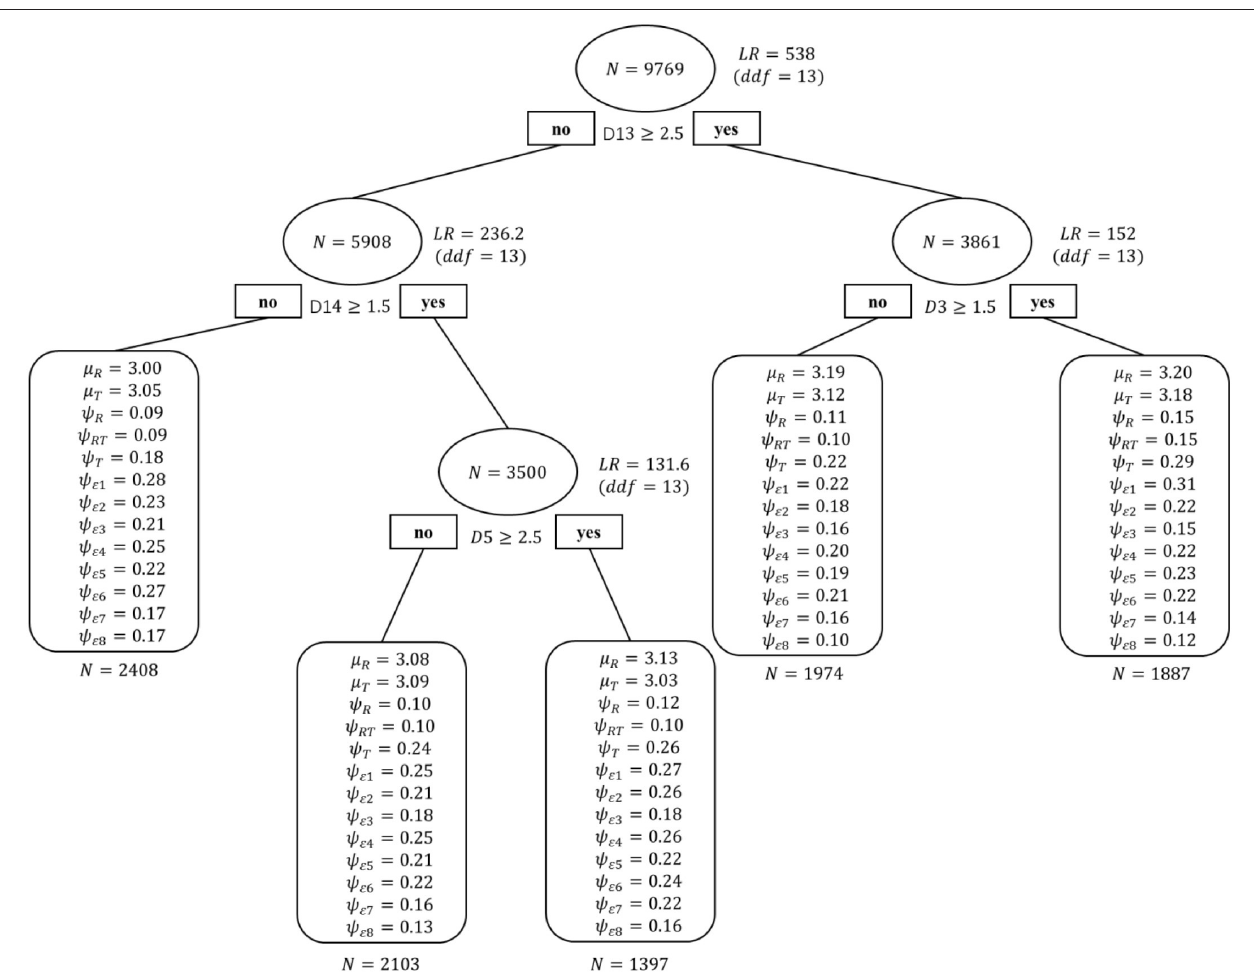
FIGURE 2 | Demographic SEM Tree for students’ attitudes toward collaboration. N , sample size at each split; LR , likelihood-ratio statistic; ddf , difference in degrees of freedom; D13, home educational resources; D14, home possessions; D5, mother’s education; D3, gender. Each parameter label corresponds to the estimate for that group from the two-factor model depicted in Figure 1B